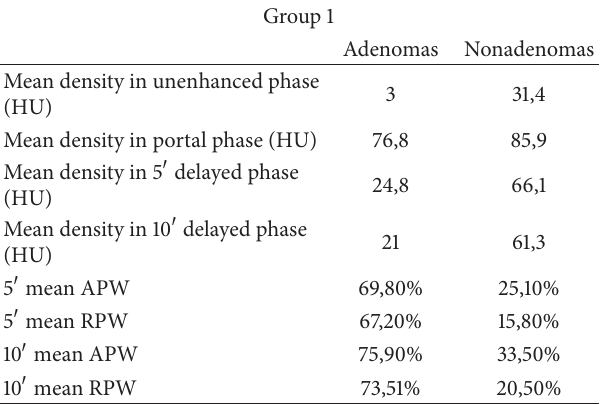
Table 1: Mean densitometric values obtained in group 1.